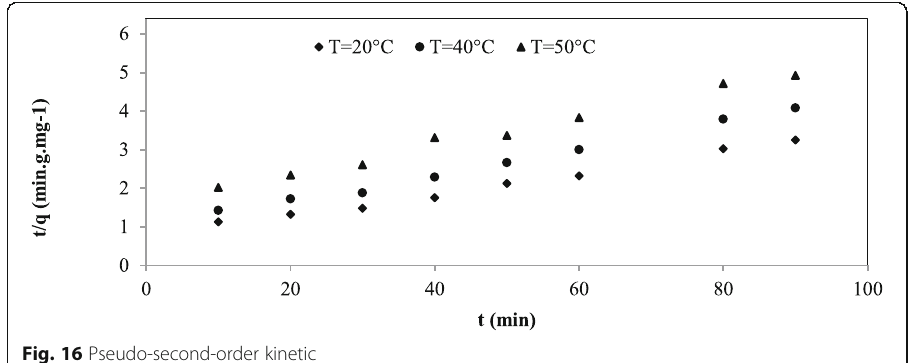
Fig. 16 Pseudo-second-order kinetic